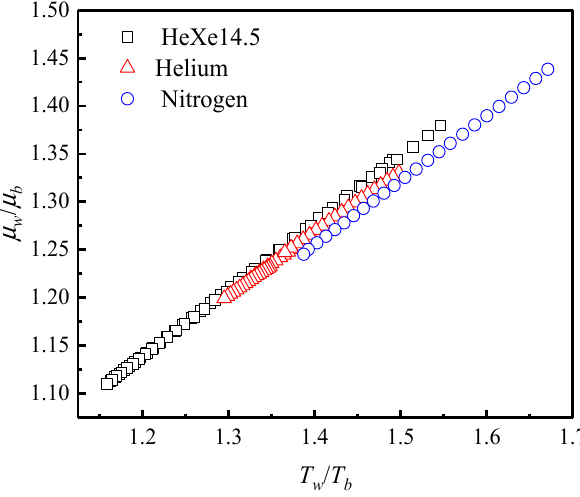
Figure 10. Variation of μ